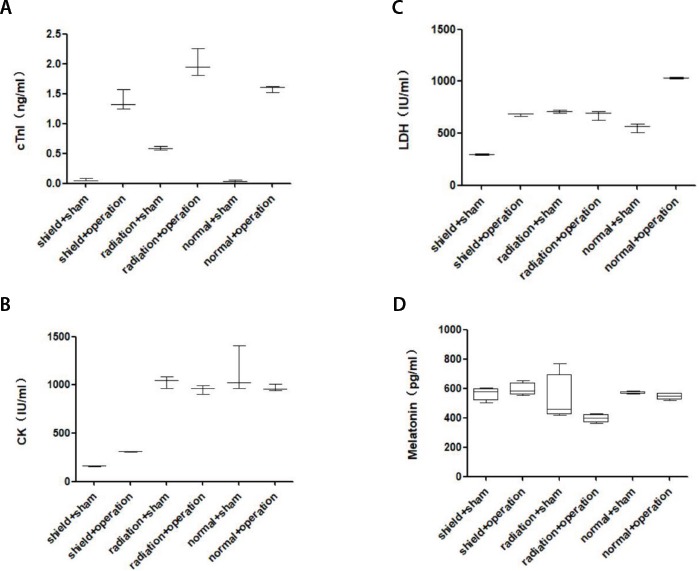
Serum biochemical indexes. A, B, and C). The cTnI, CK, and LDH were measured by automatic blood biochemical analyzer (n=3), which are specific indicators of myocardial infarction; D) melatonin was measured by ELISA kit, which protects the myocardial tissue (n=4).CK=creatine kinase; cTnI=troponin I; ELISA=enzyme-linked immunosorbent assay; LDH=lactate dehydrogenase